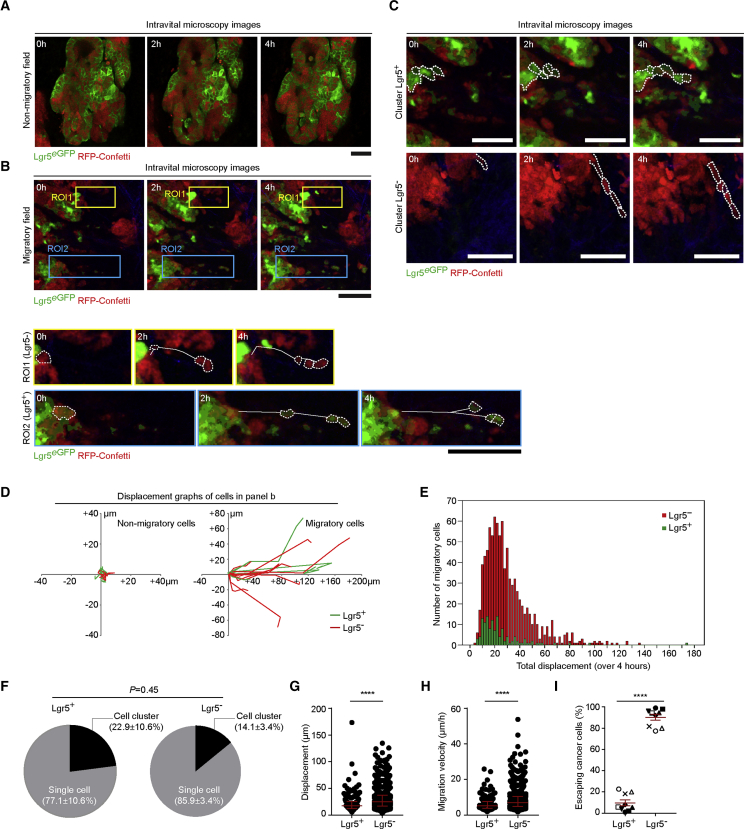
The Majority of Cells Escaping the Primary Colorectal Tumors Are Lgr5−(A) Representative time-lapse intravital images of a non-migratory field within a CRC primary tumor. Note that the resolution of in vivo images is lower than of ex vivo images because of great depth of imaging in living animals. Scale bar, 50 μm.(B) Time-lapse intravital images of a migratory field showing primary tumor cell migration of Lgr5− and cancer cells (ROI, region of interest 1) and Lgr5+ CSCs (ROI2). Dashed lines highlight the migratory cells, continuous lines mark the migratory tracks overtime. Scale bars, 50 μm. See also Videos S1 and S2.(C) Representative time-lapse intravital images of Lgr5+ CSCs (upper panel) and Lgr5− cancer cells (lower panel) moving as cell clusters (see also Videos S3 and S4). Scale bars, 50 μm.(D) Display of the migratory tracks of Lgr5+ CSCs and Lgr5− cancer cells observed in (A) (left) and in (B) (right).(E) Distribution of total displacement of Lgr5+ (green) and Lgr5− (red) migratory cells over a period of 4 h.(F) Characterization of Lgr5+ CSCs and Lgr5− cancer cells migratory mode (i.e., cells escaping as single cells or as cell clusters (i.e., maintaining cell-cell contact). Data are presented as mean ± SEM (n = 9); p values were calculated using the unpaired t test with Welch’s correction.(G and H) In vivo displacement (G) and velocity (H) of escaping Lgr5+ CSCs and Lgr5− cancer cells. Each data point represents a cell. ∗∗∗∗p < 0.0001. Red lines indicate median ± interquartile range; p values were calculated using the Mann-Whitney U test.(I) Fraction of escaping Lgr5+ CSCs and Lgr5− cancer cells observed in vivo in individual mice. Different shapes represent different animals (n = 9). Each data point indicates the average value per animal. ∗∗∗∗p < 0.0001. Red lines indicate mean ± SEM; p value was calculated using the unpaired t test.